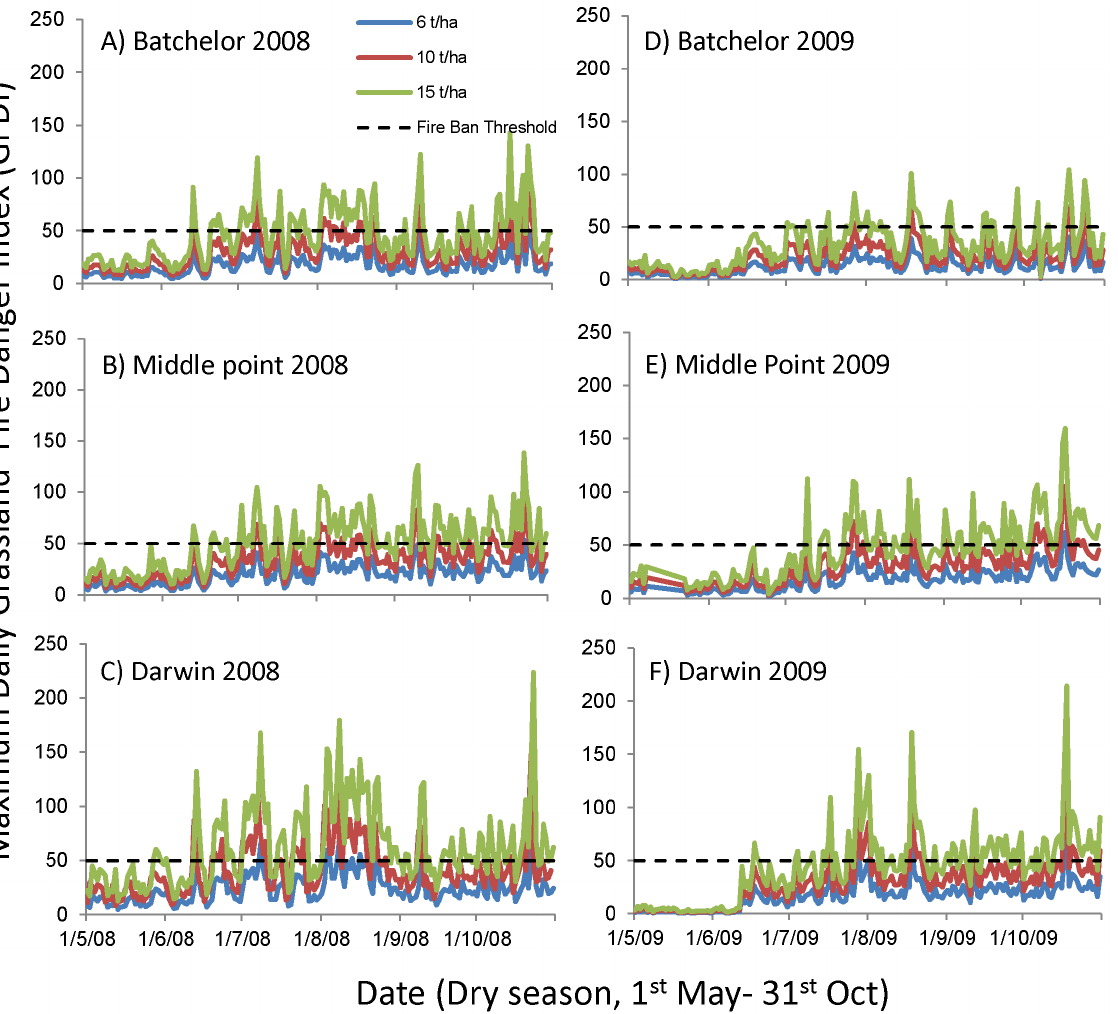
Figure 2. Daily maximum GFDI at three weather stations ((A, D) Batchelor, (B,E)Middle Point and (C,F) Darwin; Bureau of Meterology data) in 2008 and 2009 using three fuel load ( FUEL t ) scenarios: 6 (blue line), 10 (red line) and 15 t ha 2 1 (black line). GFDI of 50 is represented by the black line and is considered severe fire weather at which fire management authorities must declare fire ban days (Table 1). doi:10.1371/journal.pone.0059144.g002 PLOS ONE |